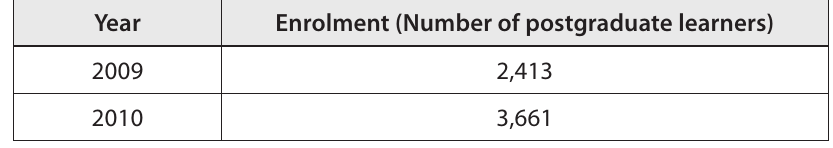
Table 3 Total OUM postgraduate enrolment in 2009 and 2010 Source: OUM annual report 2010